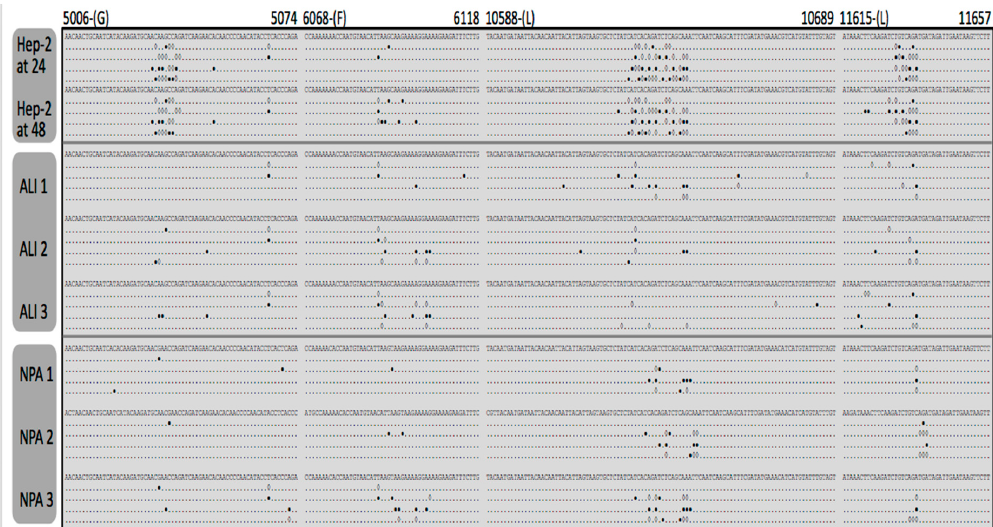
Figure 5. Representative analysis of transitions (full circles) and transversions (open diamonds) resulting from the minor nucleotide variants at exemplar positions of the HRSV genome (as indicated by nucleotide number) for the A2 strain found either in the nasopharyngeal aspirates, the air liquid interface cultures, or the Hep2 cells. For each condition, the consensus sequence (con) is shown on the first line. The following four lines represent each of the four nucleotides found as minor variants. The cut-off value was 0.5%, and the region of the genome shown is indicated by the bold numbers at the top.